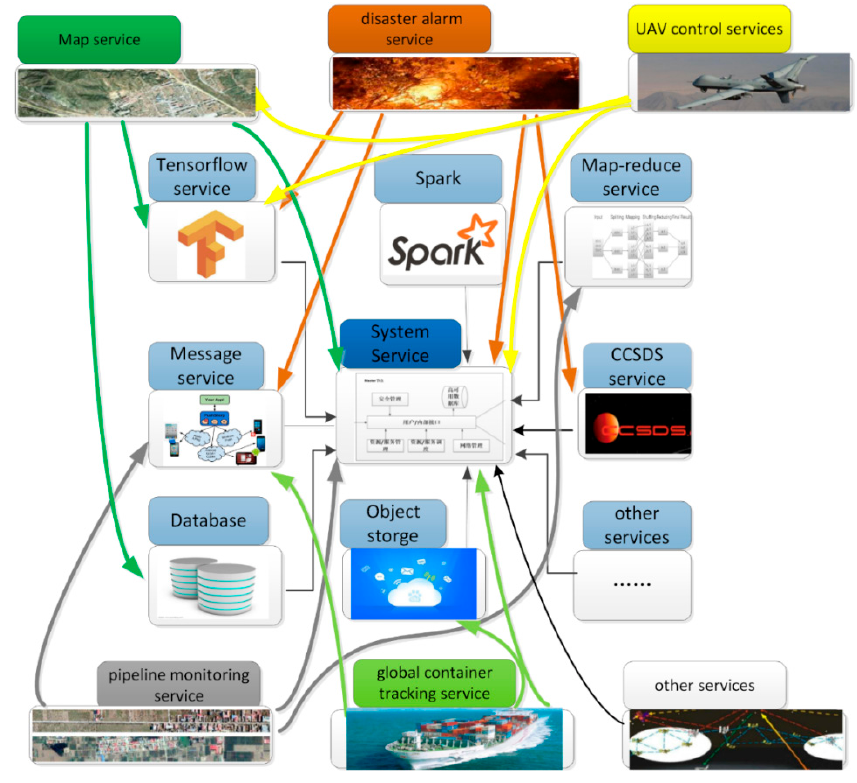
Figure 3. 5GsatEC services.